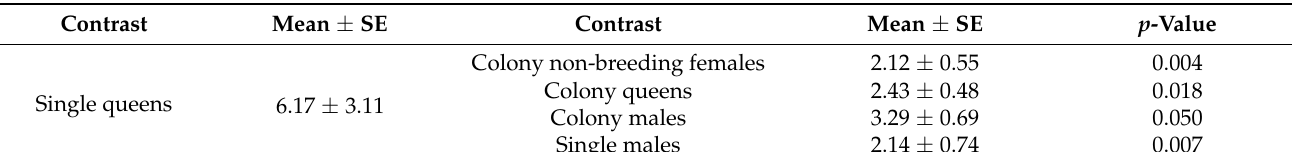
Figure 1. Latency to enter the first tunnel (±SE) ( A ) and total duration spent in tunnels (±SE) ( B ) by colony- and single-housed Damaraland mole-rats in an open-field box.